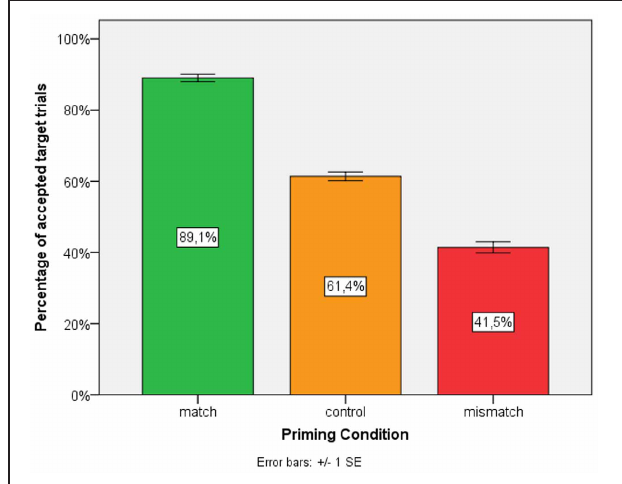
FIGURE 3 | Percentage of accepted target trials.